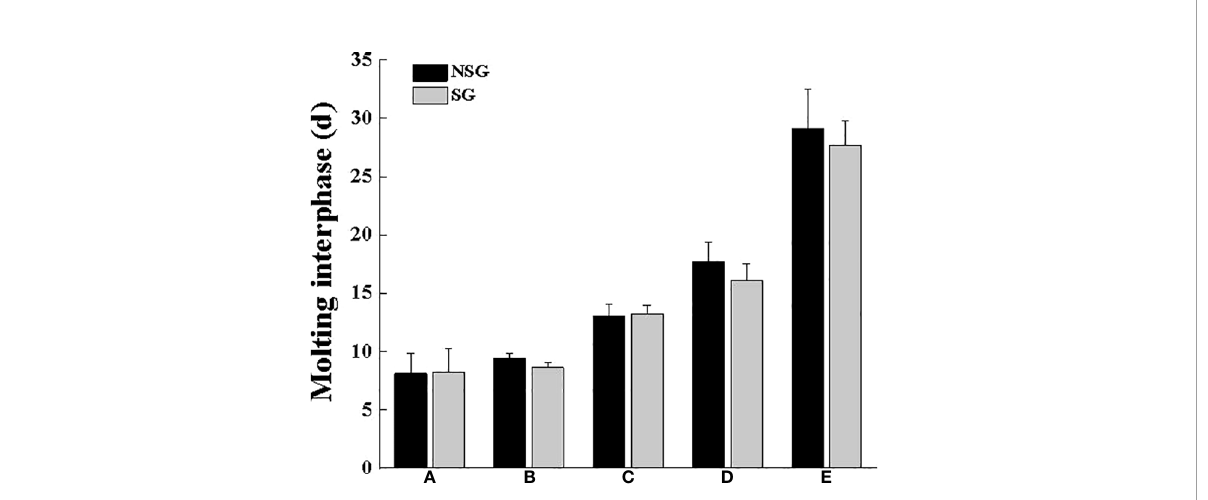
FIGURE 7 Molting interphase of swimming crab with different body weight groups between NSG and SG. Unmarked letters indicate no signi fi cant difference ( P > 0.05).